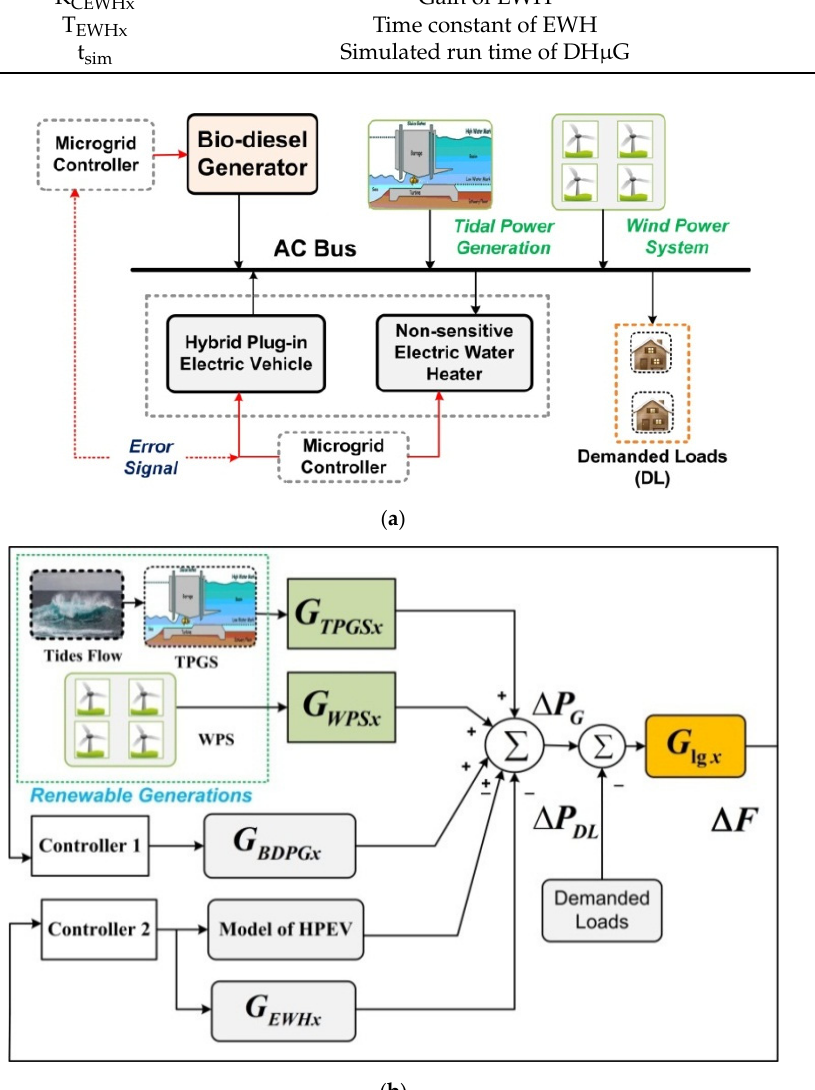
Figure 1. ( a ) Schematic diagram of the proposed system, ( b ) Block diagram depiction of proposed microgrid simulink model.